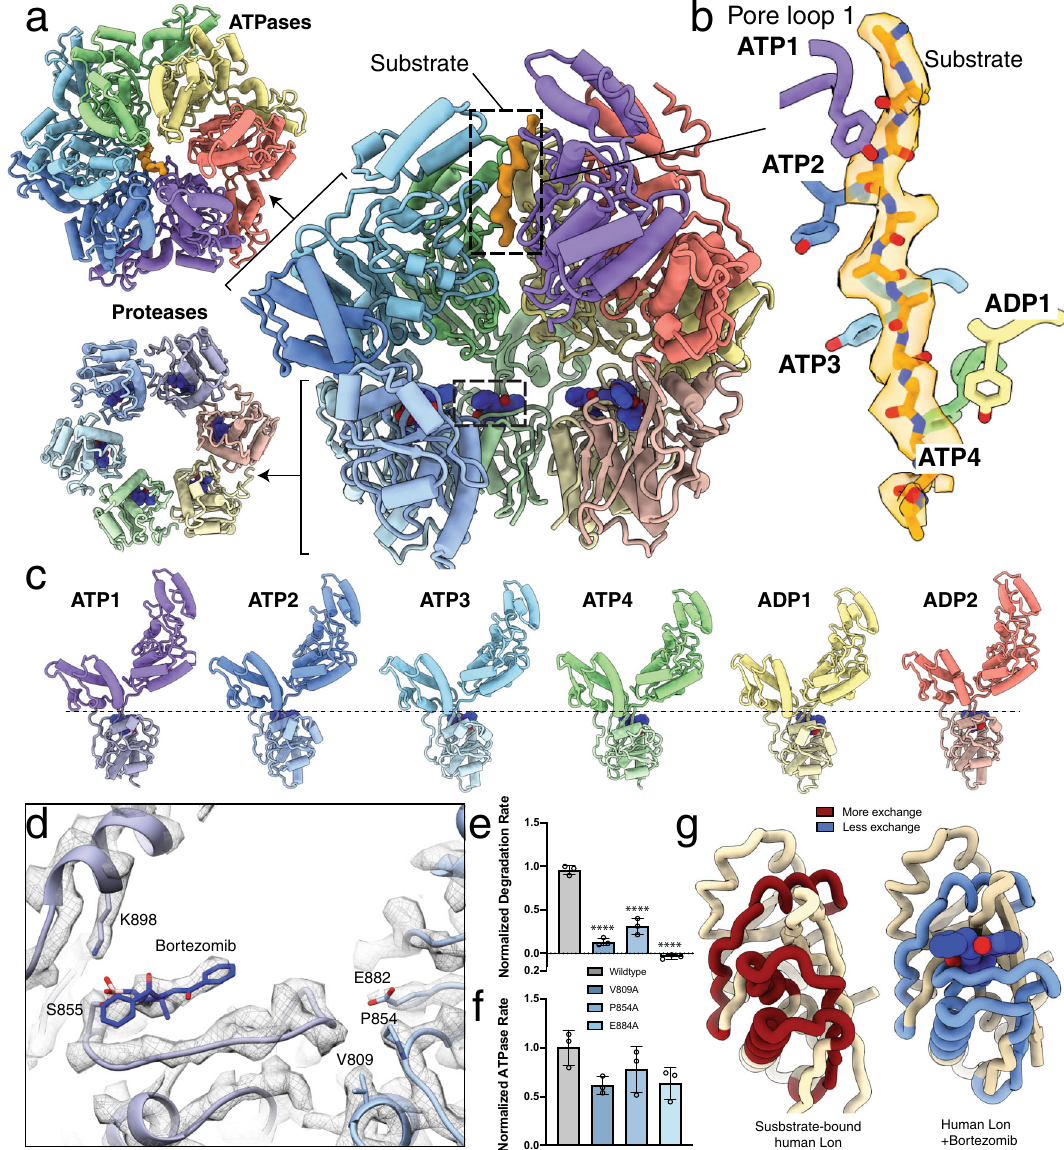
Fig. 4 Bortezomib induces a sixfold symmetrization of the LONP1 protease domains and promotes activation of the proteolytic active site. a Two external axial views of the bortezomib- and substrate-bound human LONP1 Bz atomic model (left) is shown next to a cutaway lateral view of LONP1, using the same representation and coloring as in Fig. 1. Bortezomib (blue) bound within the protease active sites are shown using a sphere representation, with one bortezomib molecule denoted by a dashed box. b A twelve-residue polyalanine chain is modeled into the substrate density within the central channel of the LONP1 Bz structure, shown as in Fig. 2. The pore loop 1 Y565 residues from subunits ATP1-4 maintain intercalating, zipper-like interactions with substrate; however, Y565 from ADP1 in LONP1 Bz is positioned further from substrate as compared to our substrate-bound structure (see Fig. 2). c When the subunits are positioned side-by-side, the protease domains are aligned along a single plane. d Bortezomib covalently attached to S855 in ATP1 is shown using a ribbon representation within a mesh representation of the cryo-EM map, where the loop containing the catalytic serine S855 is observed extended toward the neighboring protease domain and interacting with conserved residues V809, P854, and E882 from the neighboring protease domain, shown in blue. e , f Graphs showing rates of FITC-casein degradation ( e ) or ATPase rate ( f ) for LONP1 harboring alanine mutations in the conserved residues V809, P854, and E882 involved in stabilizing the catalytic loop in the active conformation of the protease active site. Data are presented as bar graphs showing mean values with error bars showing standard deviation from three independent replicates. **** p < 0.0001 relative to wild type calculated by one-sided ANOVA. g A single protease domain is shown as a worm representation from the substrate-bound LONP1 structure in the absence (left) and presence (right) of bortezomib. Regions showing a decrease in D 2 O exchange measured by HDX-MS upon bortezomib binding are colored red in the inactive state (signifying greater exchange) and blue in the bortezomib-bound state (signifying decreased